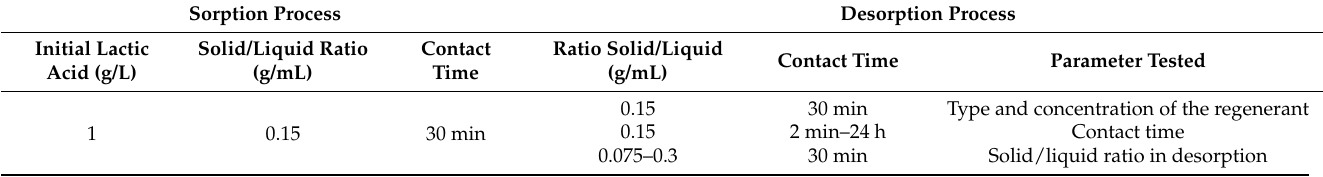
Table 3. Study of the desorption process changing the type and concentration of regenerant, contact time and the solid/liquid ratio. Sorption Process Desorption Process Initial Lactic Solid/Liquid Ratio Acid (g/L)